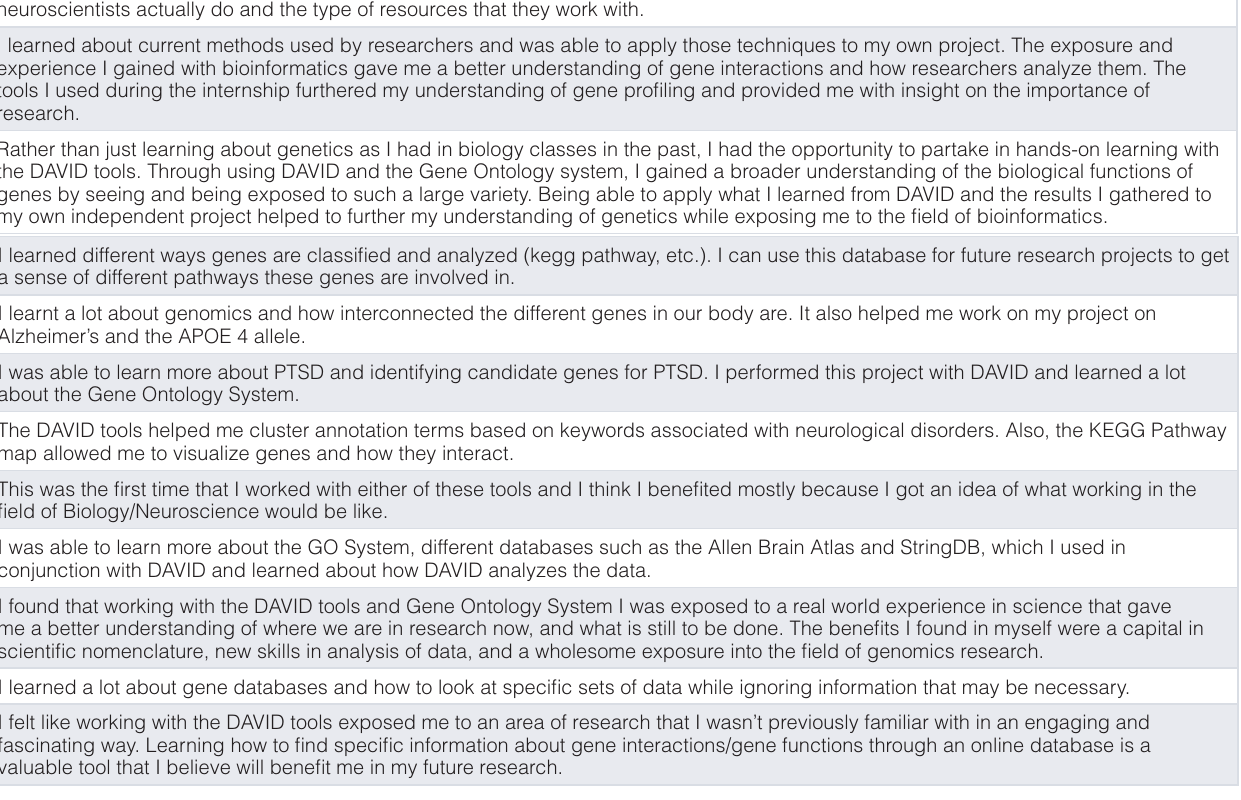
Table 2. Student Short Answer Responses to question 3a. (Question 3: Did you benefit intellectually from working with the DAVID tools and learning about the Gene Ontology System?) 3a: If yes, please explain how?. Through this internship using DAVID, I was exposed for the first time to the field of bioinformatics and the gene ontology system. I learned more about the role genes play in neurological disorders in humans. I also got a glimpse of what biomedical researchers and neuroscientists actually do and the type of resources that they work